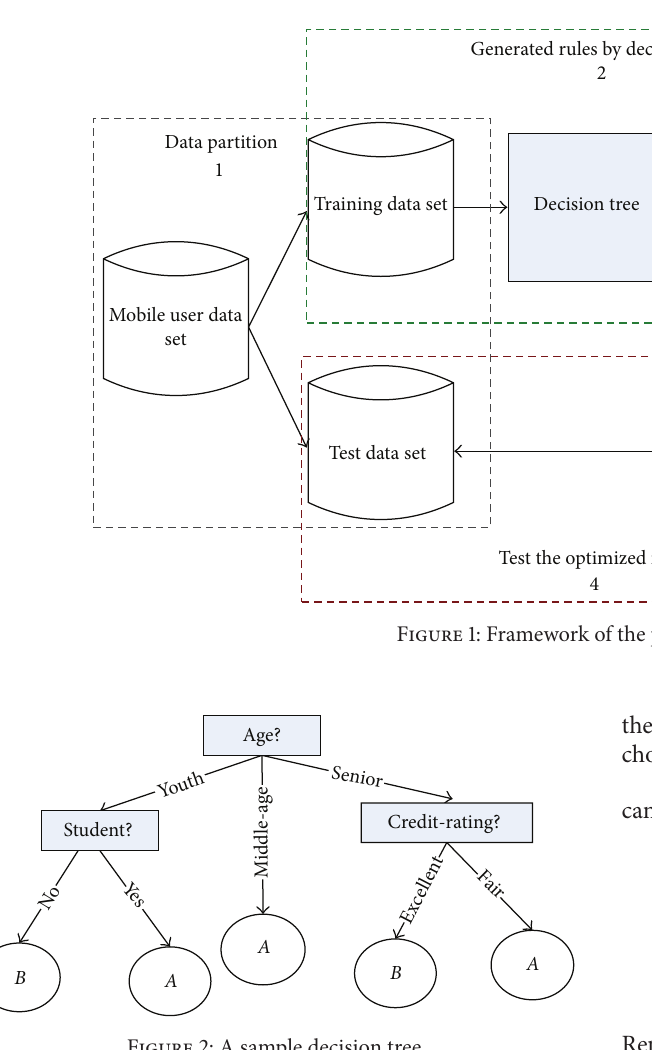
Figure 2: A sample decision